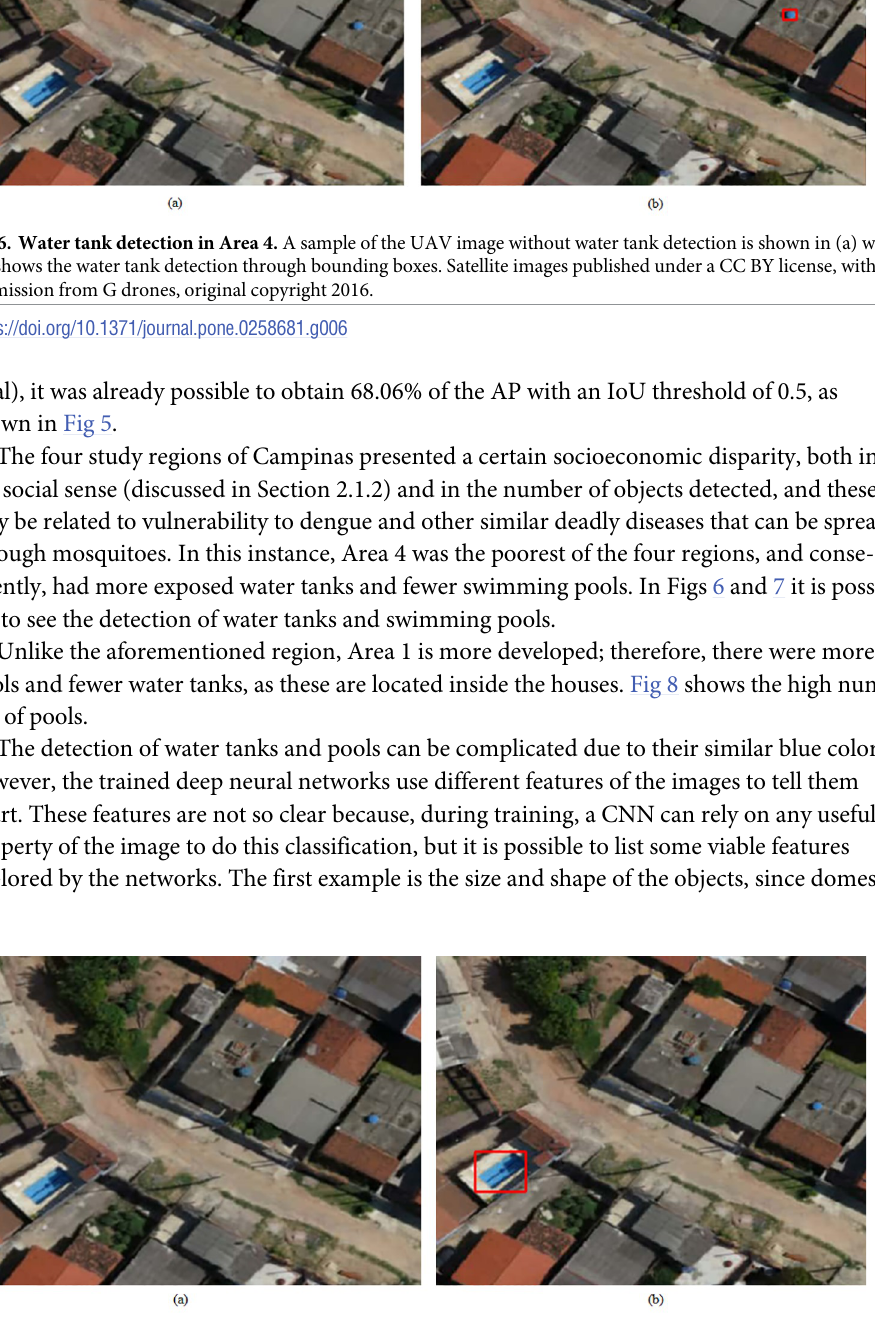
Fig 7. Swimming pool detection in Area 4. A sample of the UAV image without swimming pool detection is shown in (a) while (b) shows the swimming pool detection through bounding boxes. Satellite images published under a CC BY license, with permission from G drones, original copyright